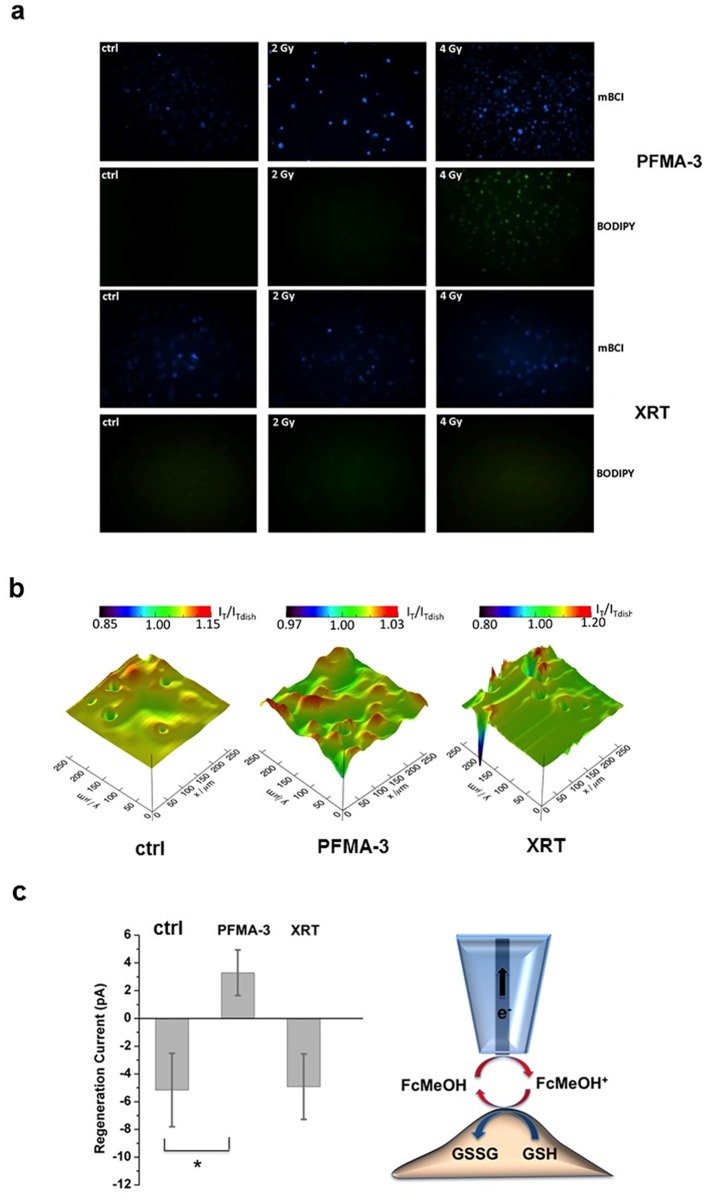
PFMA-3 induced glutathione and lipid peroxidation production greater than XRT.a) Visualization of the SK-Mel28 living cells 3 hrs after irradiation with PFMA-3 or XRT (at 2 and 4 Gy) and of those non irradiated (ctrl) loaded by the fluorescent dyes monochloromobimane (mBCl) and boron-dipyrromethene (BODIPY) for a qualitative GSH and lipid peroxidation detection, respectively. Epifluorescence images at 100 × of magnification. b) Representative FcMeOH/SECM images in constant height mode of non irradiated (ctrl) and irradiated SK-Mel28 cells at 4 Gy by PFMA-3 and XRT. The regeneration currents recorded were reported as a percentage increase/decrease of the signal in respect to the one recorded at the same tip-dish distance but far away from cells (IT/ITdish). c) Histogram reported the values obtained by computing the mean (± SEM) regeneration current recorded on 4 different cells selected from the scanning electrochemical microscopy images. Asterisks indicated statistically significant differences (*P <0.05).